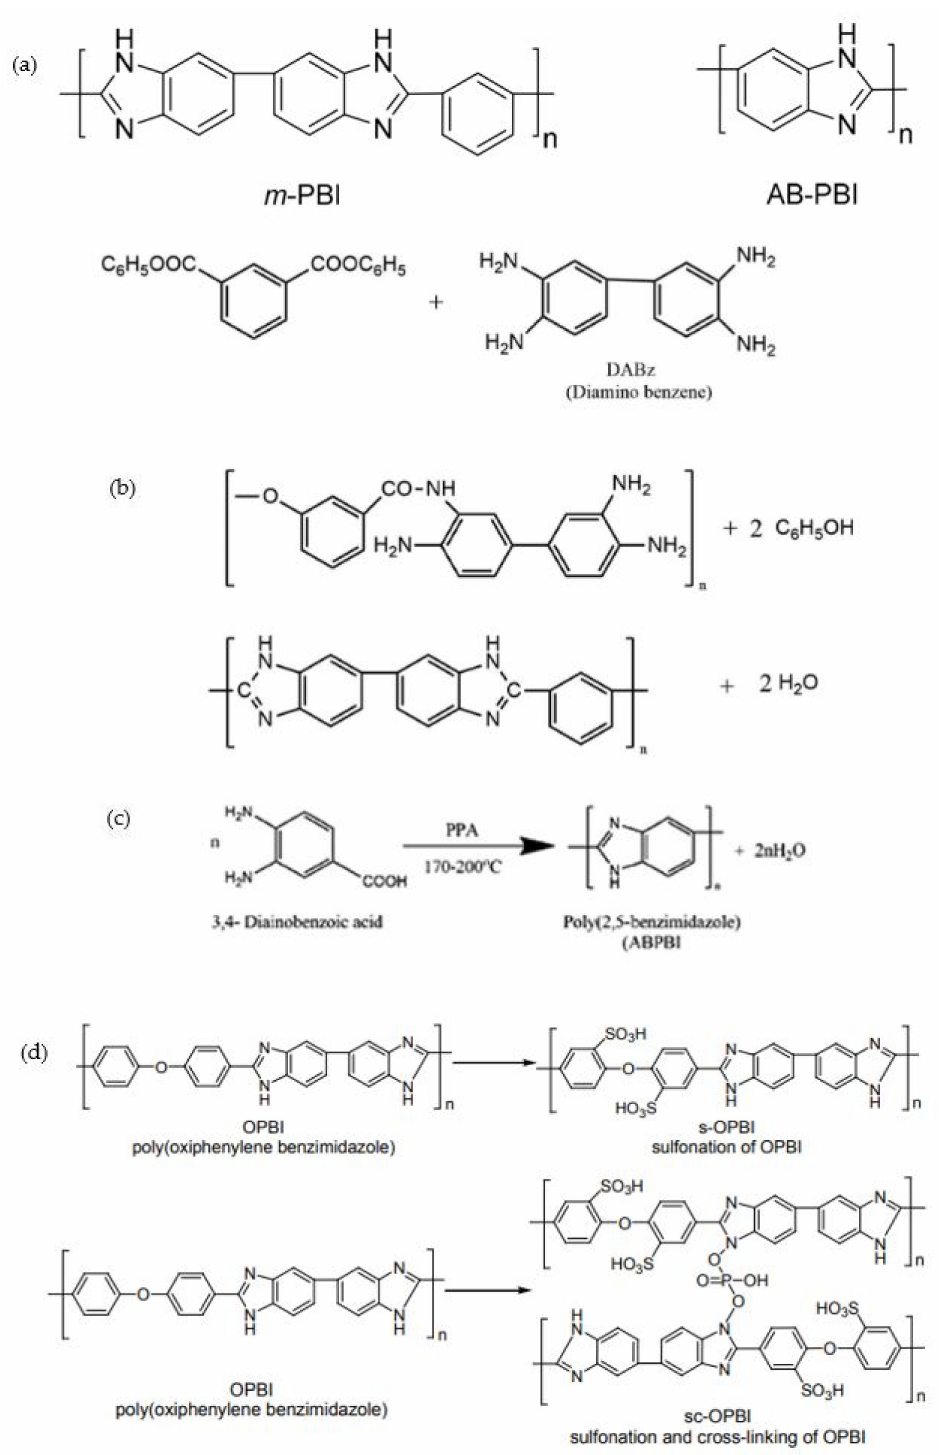
Figure 3. Chemical structure of ( a ) monomers for the most applied PBI polymers [8]. ( b ) Synthesis of m -PBI [3] and ( c ) AB-PBI polymers [41]. ( d ) Synthesis of the linear and cross-linking sulfuric acid-OPBI polymer